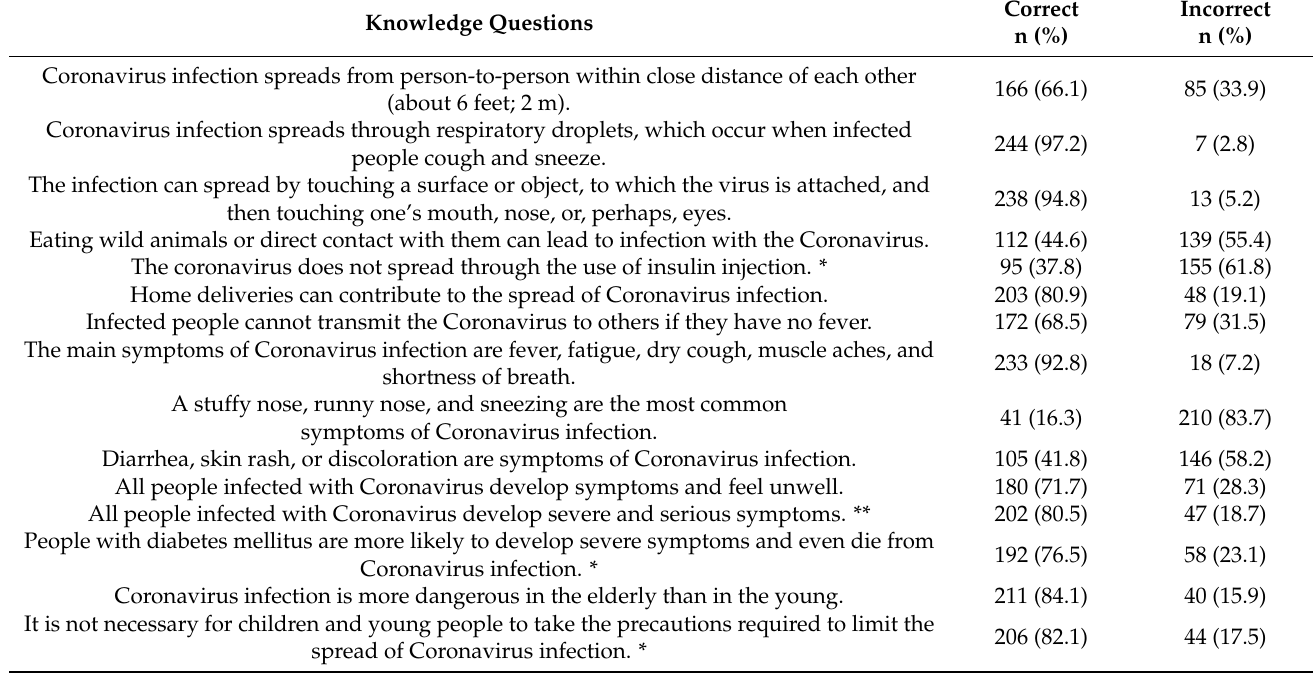
Table 4. Patients’ responses to questions related to knowledge about COVID-19 in terms of transmis- sion, clinical presentation, and high-risk groups (n = 251).